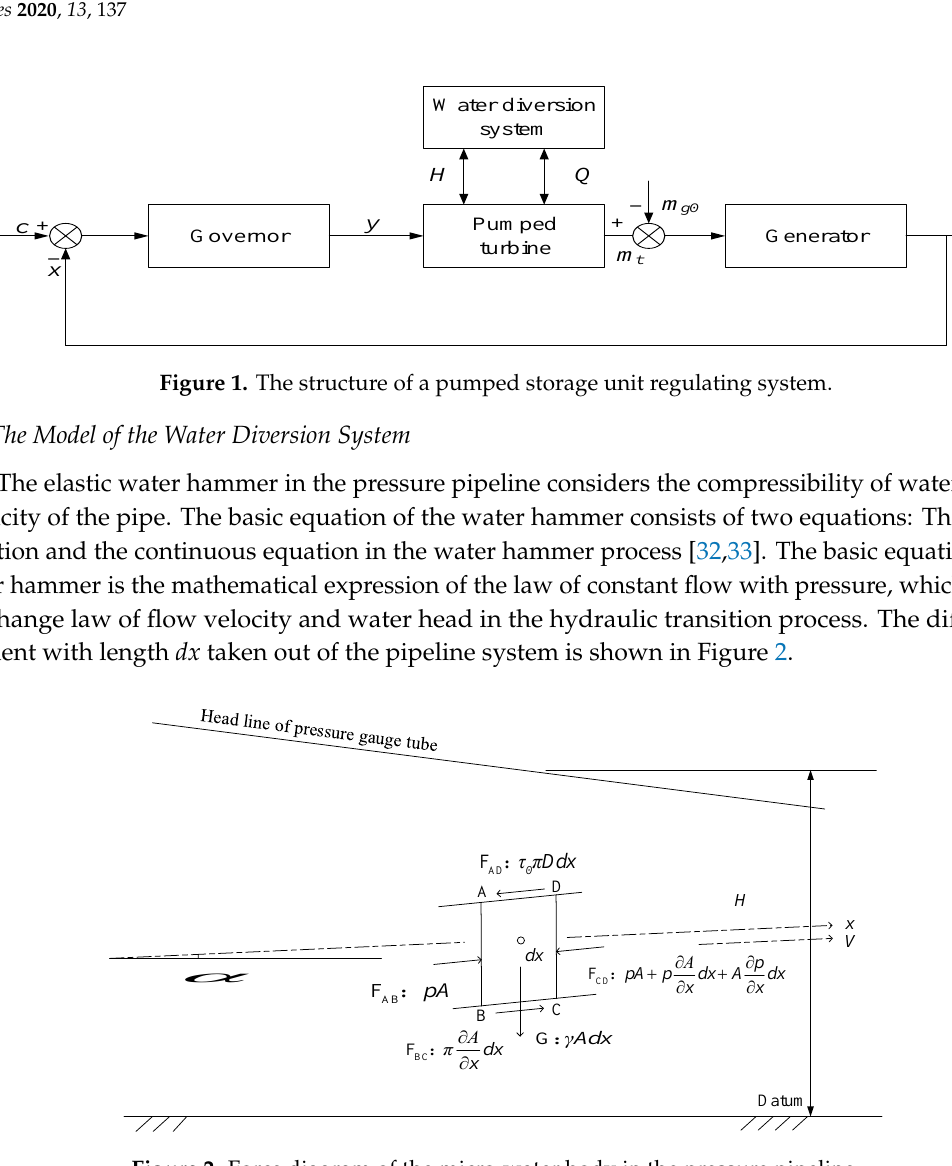
Figure 2. Force diagram of the micro-water body in the pressure pipeline.